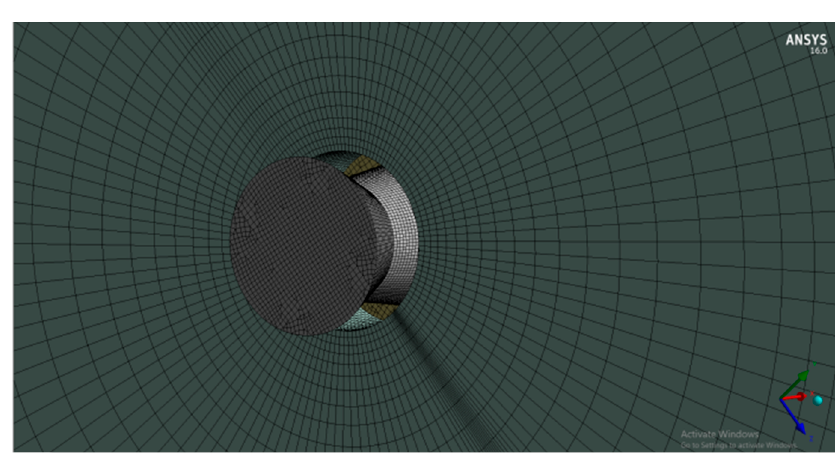
Figure 4. Enlarged view of finely meshed nozzle region.